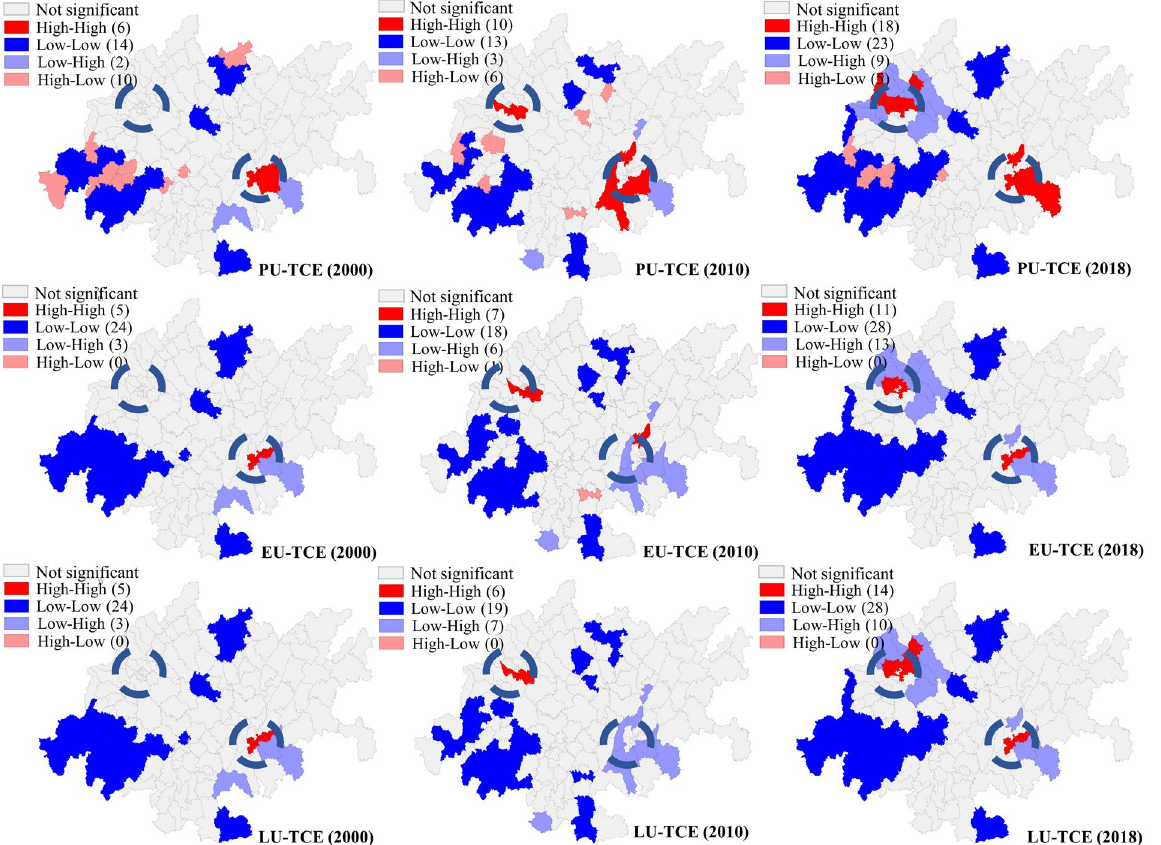
Figure 8. Bivariate spatial autocorrelation between carbon emissions and multi-dimensional urban-